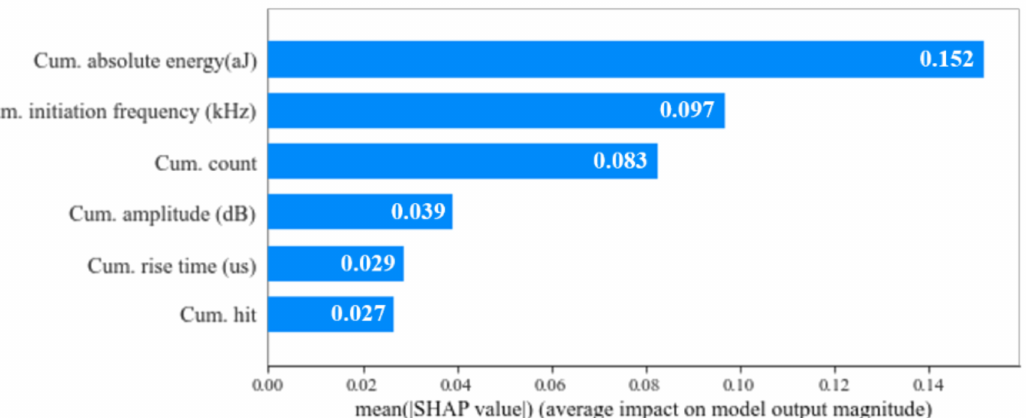
Figure 14. Averaged absolute values of SHAP. The result showed that the cumulative absolute energy is the highest value among the several AE parameters. Obviously, other parameters also contribute to the prediction of rock damage. These results provide rationality for considering various AE parameters for predicting the degree of rock